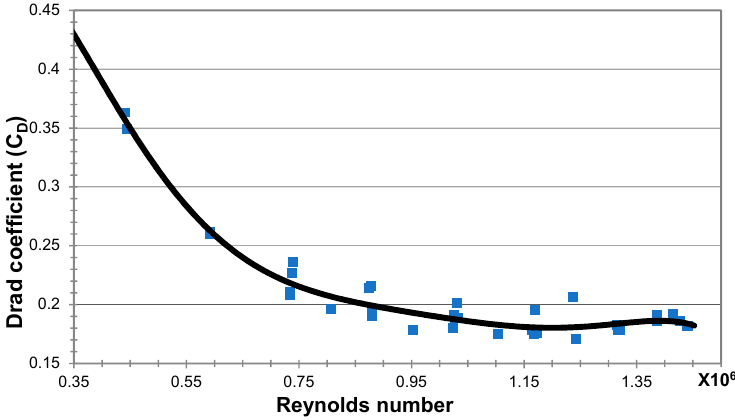
Figure 10. The drag coefficient measured on the MRJ propulsor in the tow pool.